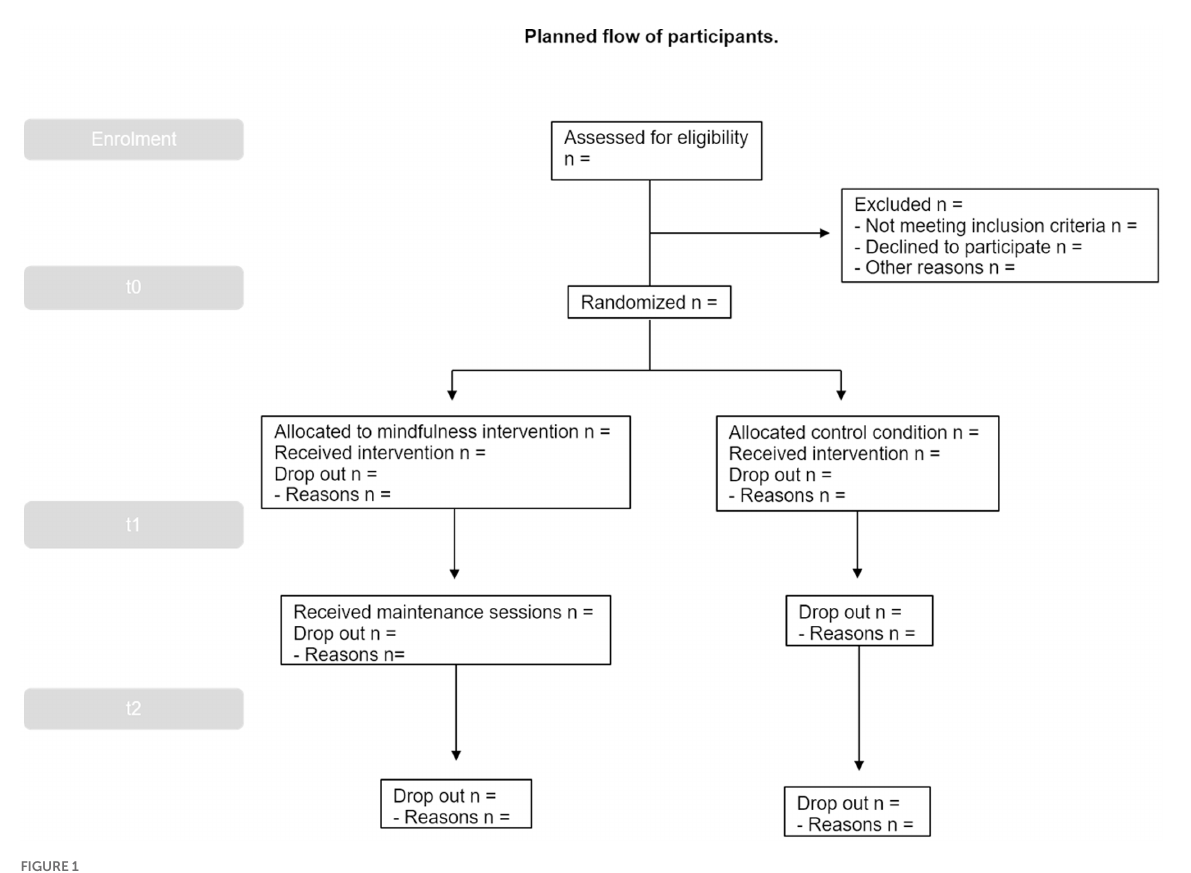
FIGURE 1 Planned flow of